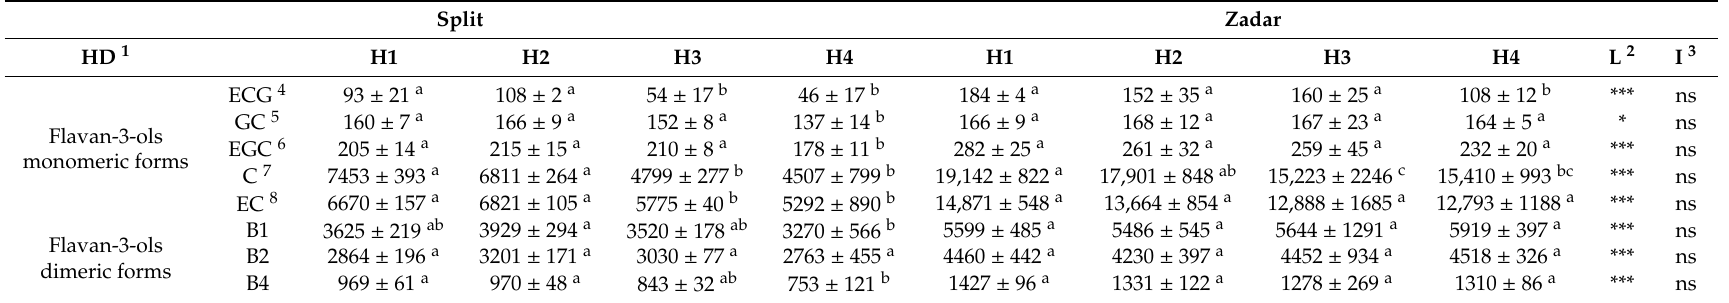
Two-way ANOVA showing mean separation of the flavonoid components of Plavac Mali harvested at four di ff erent dates 1 HD (H1, H2, H3 and H4) at two locations ( 2 L; Split and Zadar) and the 3 I interactive e ff ect of harvest date and location (ns: not significant; * p ≤ 0.05; *** p ≤ 0.001). Mean values ± standard deviation ( n = 3) within the same line followed by di ff erent letters indicate significant di ff erences according to Fisher’s LSD test at p ≤ 0.05 between di ff erent harvest dates, separately at each growing location as determined by one-way ANOVA. 4 ECG-epicatechin-3- O -gallate, 5 GC-gallocatechin, 6 EGC-epigallocatechin, 7 C-catechin, 8 EC-epicatechin. Concentrations of flavonoids are presented in units of mg kg − 1 dry